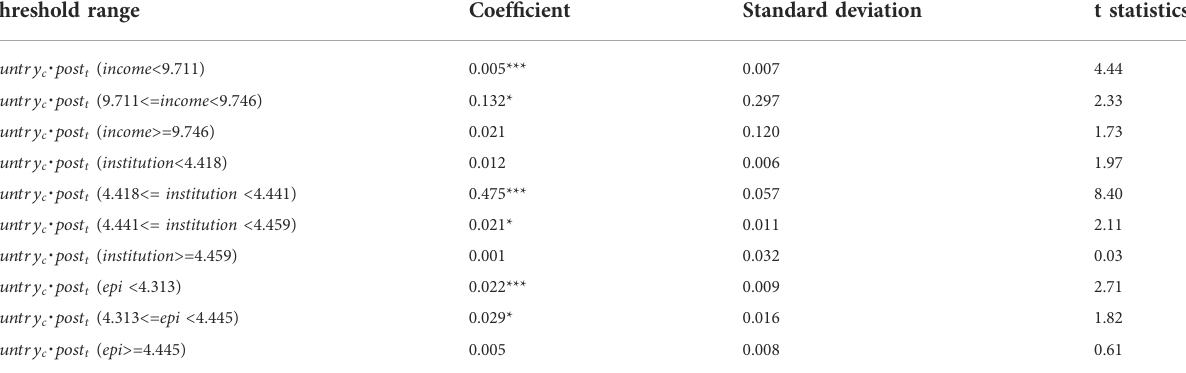
TABLE 6 Results of the threshold test.